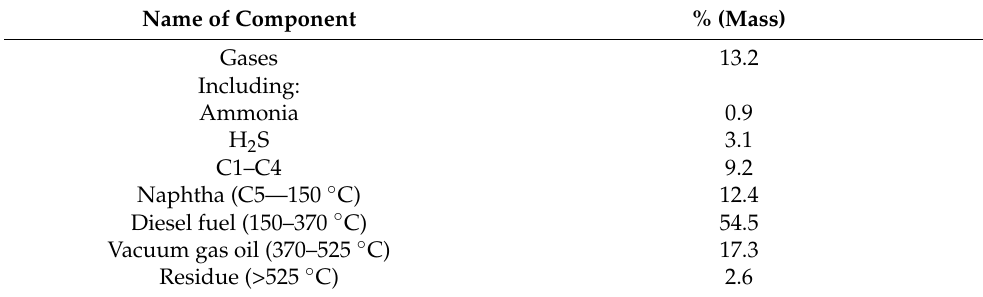
Table 5. The product yield after vacuum-residue upgrading in two stages: thermal hydrocracking and